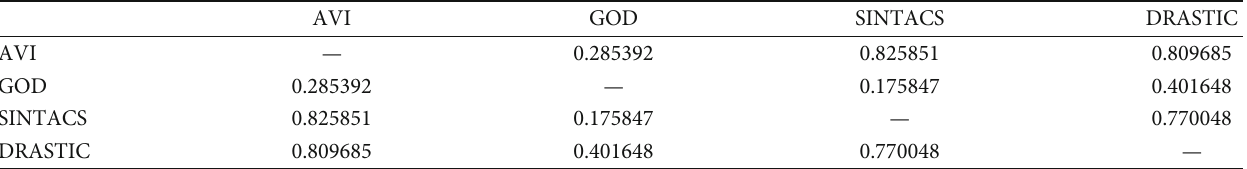
Table 15: A t -test (two-tailed) matrix between the maps computed using AVI, GOD, SINTACS, and DRASTIC. AVI GOD SINTACS AVI